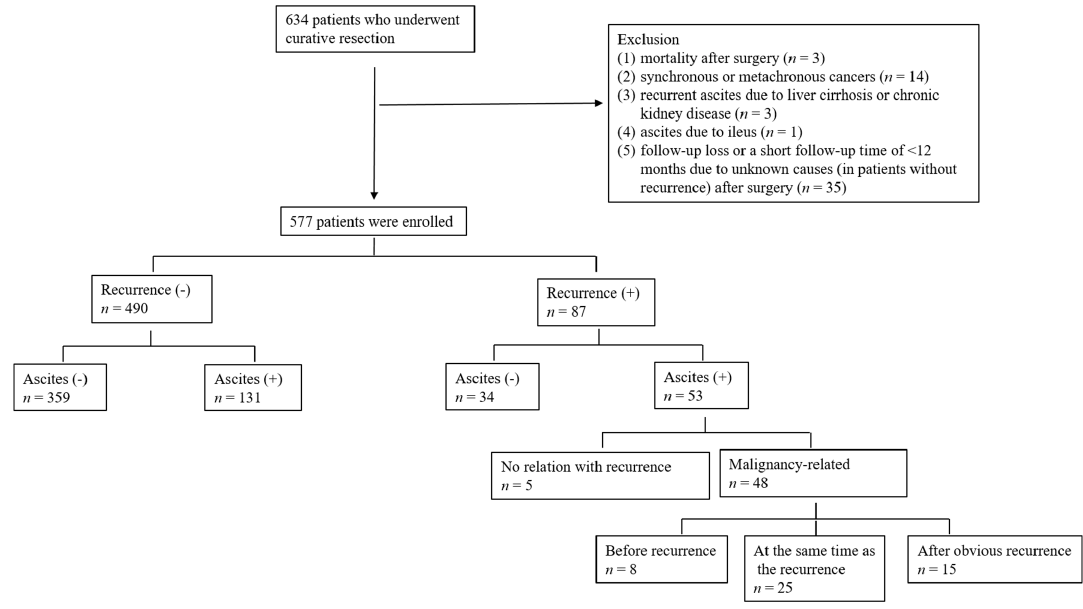
Figure 2. Study population.: +, presence; -, absence.